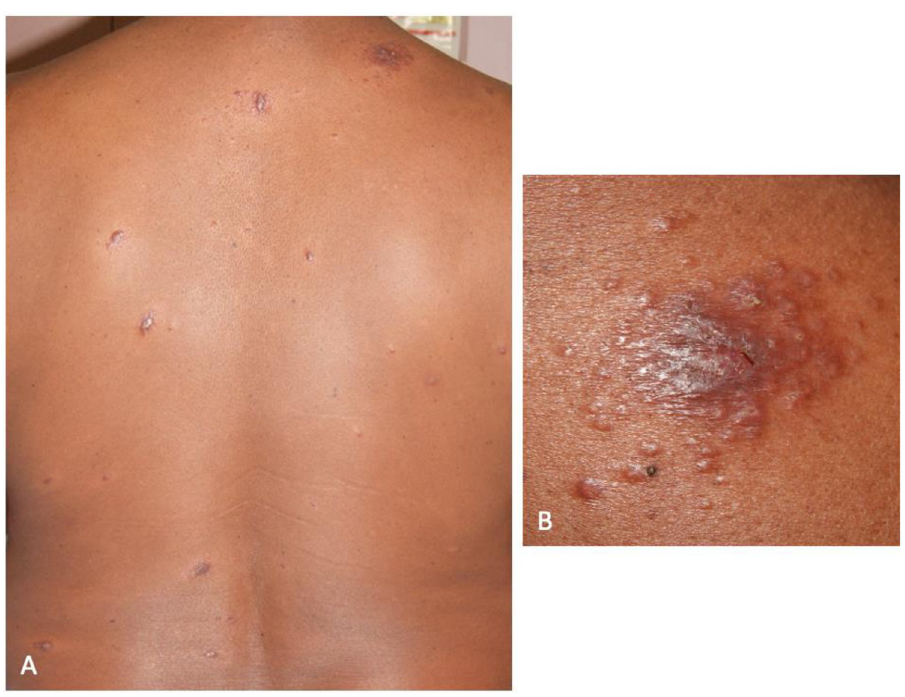
Fig 5. IRIS type 1 after introduction of HAART in patient 6: BT leprosy in T1R on the trunk. A: multiple inflammatory papulo-nodular lesions. B: close-up view of the lesion on the right shoulder.